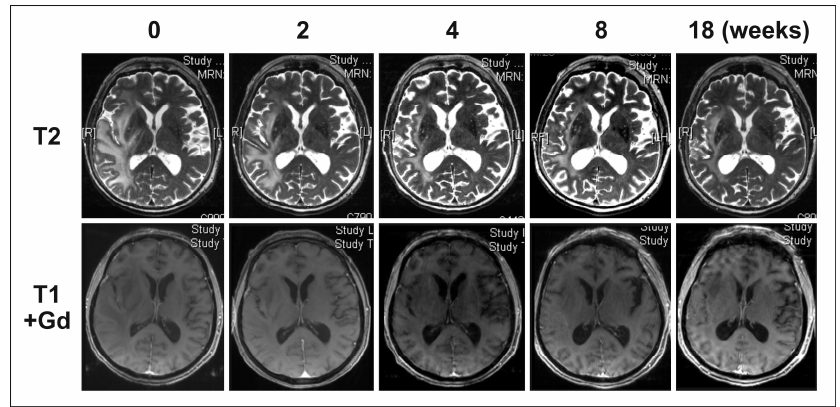
Figure 2. Exemplary magnetic resonance imaging (MRI) of Patient 7: non-contrast enhancing lesion. T2 sequences and T1 sequences after intravenous gadolinium administration were obtained at Weeks 0, 2, 4, 8, and 18 after BEV therapy initiation. While throughout the observation period no contrast enhancement was observed on this level, the T2 sequences from Week 18 show non-enhancing progressive disease.